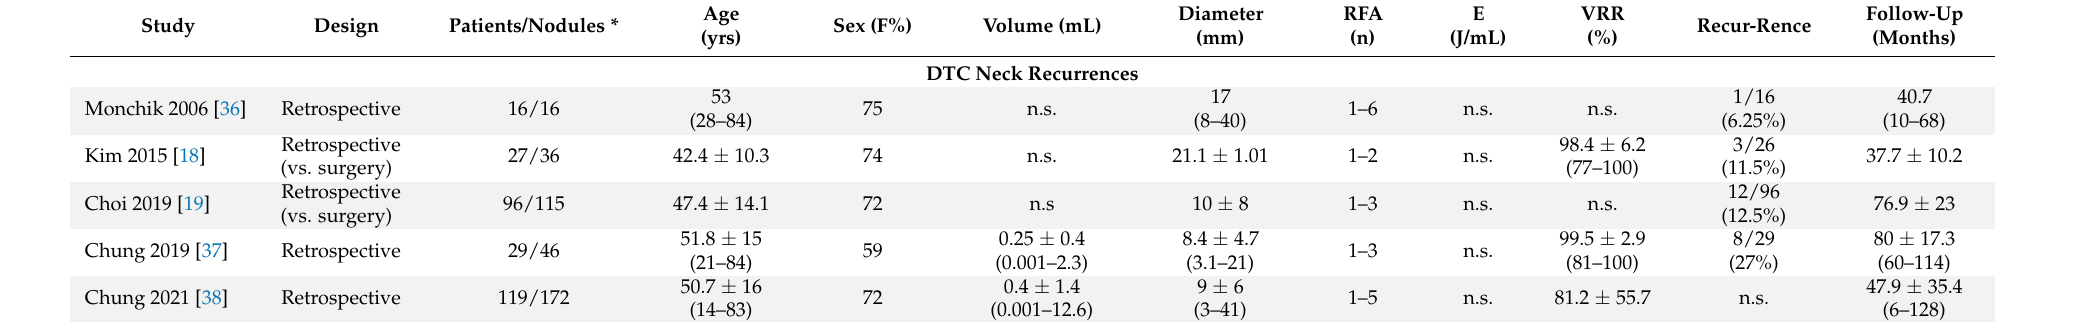
Table 4. Studies on RFA long-term outcomes in patients with DTC neck recurrences.